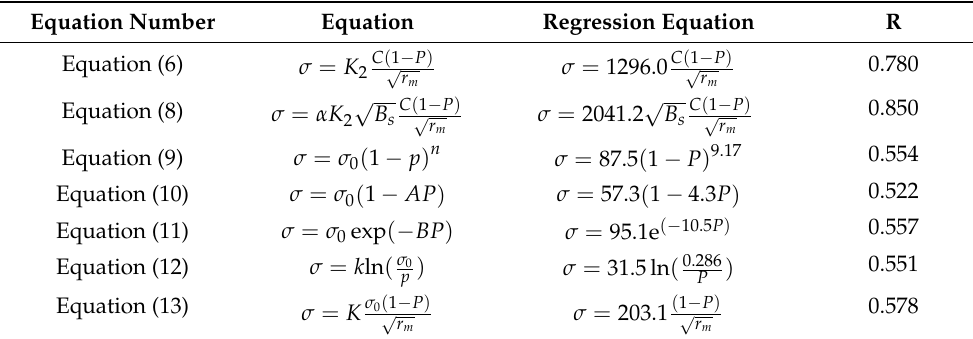
Table 5. Regression results of strength